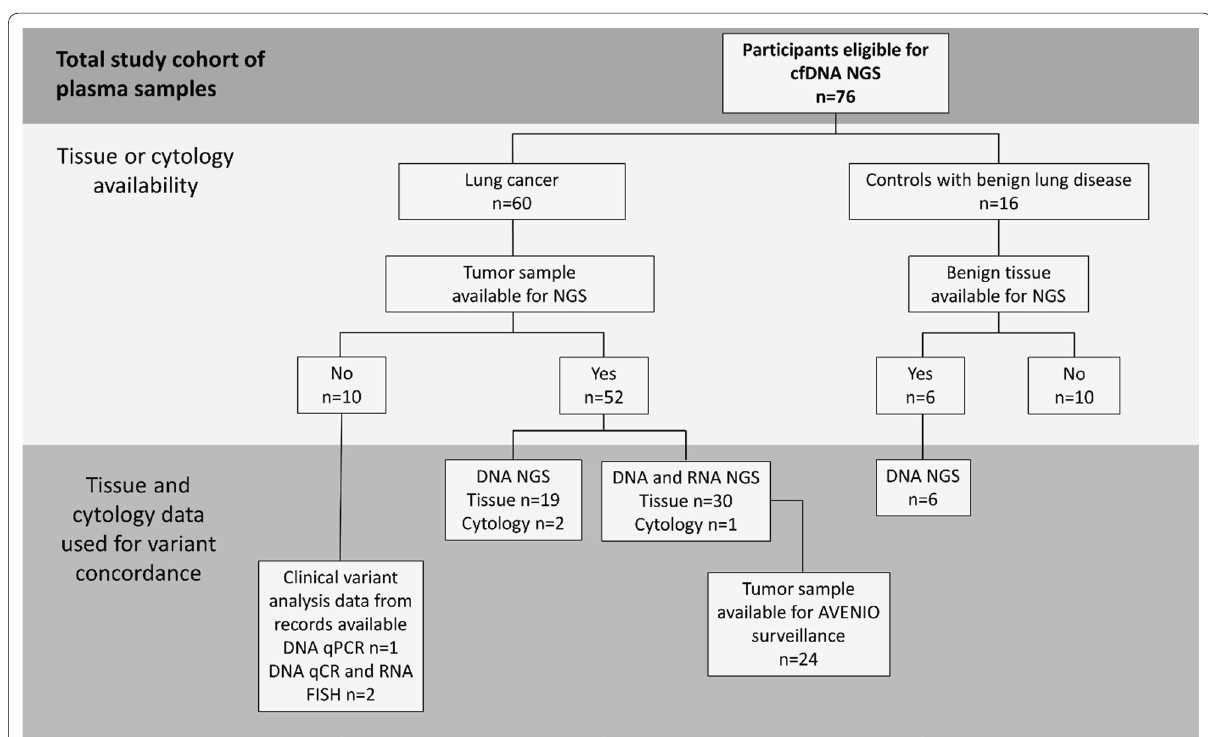
Fig. 1 Inclusion for variant agreement between tumor and plasma samples. The total study cohort consisted of patients with cfDNA AVENIO NGS performed (n 77). One cfDNA plasma sample was excluded due to too low unique molecular depth (< 500 = or benign lung tissue and paired plasma, clinical variant analysis data from DNA and RNA NGS was retrieved. When tumor tissue or cytology was insufficient for NGS, clinical variant analysis data was retrieved from qPCR or FISH for DNA or RNA, respectively. A subset of patients (n additional tumor material was available, was also analyzed with the corresponding AVENIO kit as for